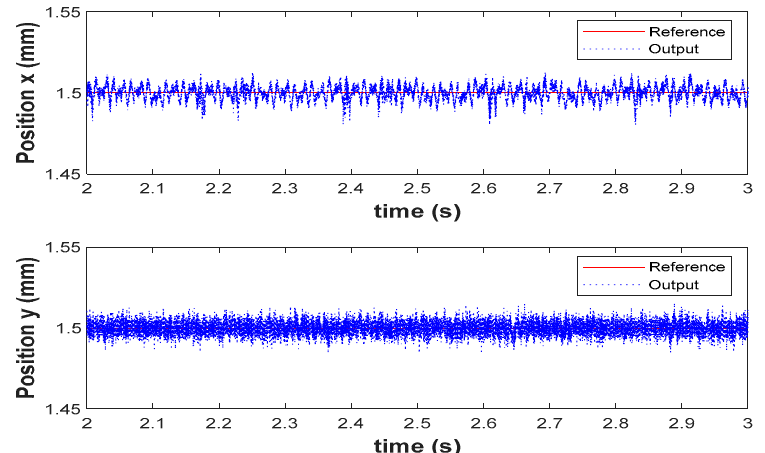
Figure 11. Reference command tracking of AMB in both horizontal and vertical planes.